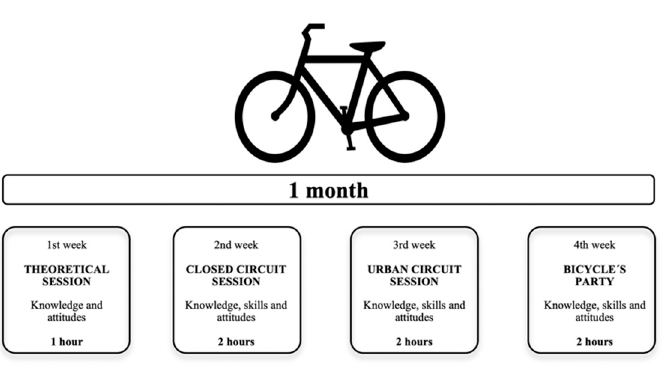
Figure 4. Structure and duration of the school-based intervention to promote cycling to school.